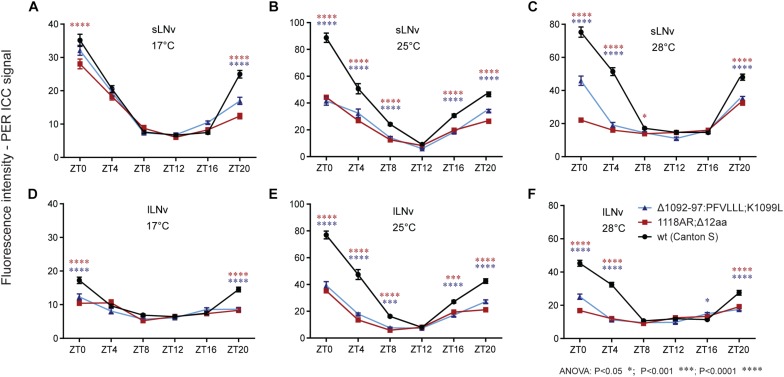
Immuno-localization of PER in small and large ventrolateral neurons (s-LNv, l-LNv). Relative quantifications show role of (A–F) temperature on PER immunoreactivity within genotype. Only statistical difference between wt and mutants is shown for each ZT. For differences, see Supplementary Figure S6. s-LNv and l-LNv were plotted separately.